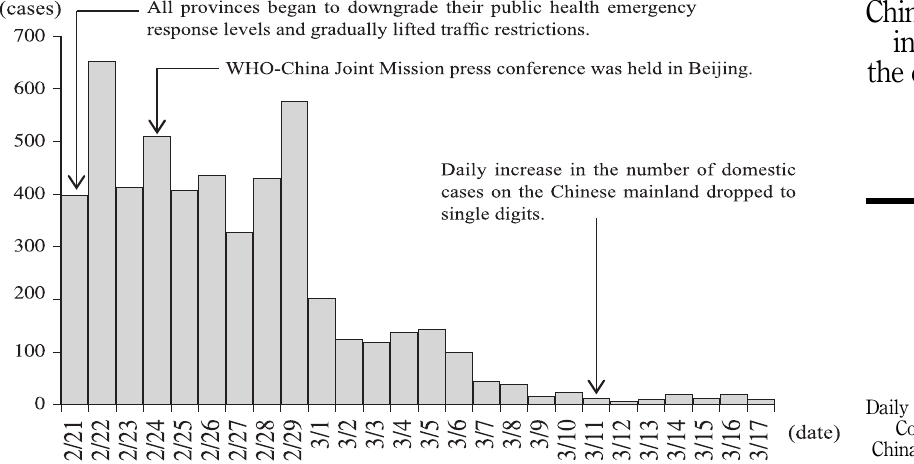
Figure 3. Daily Figure for Newly